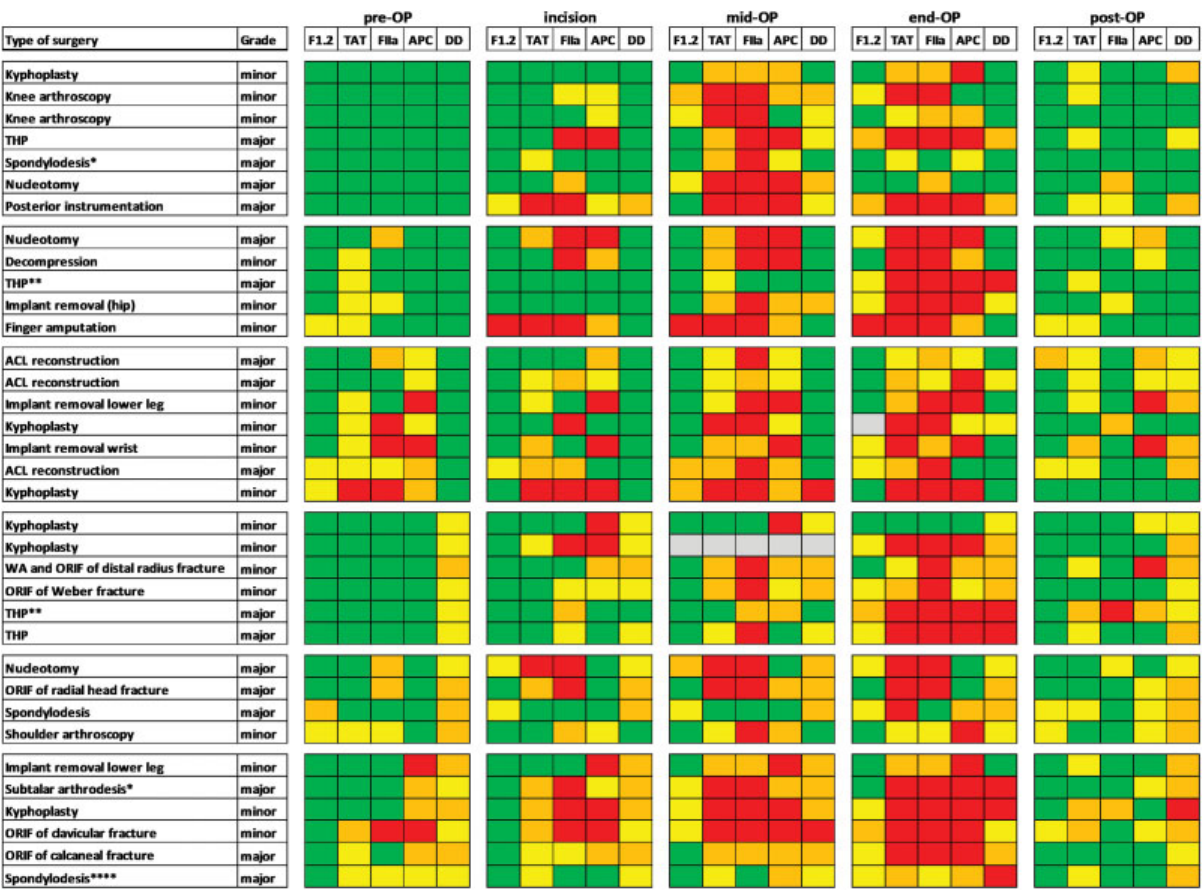
Fig. 3 Digital dynamics of surgery-induced changes in activity patterns. The changes in plasma levels of prothrombin fragment 1.2 (F1.2), thrombin – antithrombin (TAT) complexes, thrombin (FIIa), APC, and D-dimer (DD) are expressed in relation to the respective upper limit of the reference ranges. Green , no increase; yellow , up to twofold-increase; orange , up to fi vefold-increase; red , more than fi vefold-increase; gray , not measured. The number of stars shown behind the type of surgery represents the number of RBCs